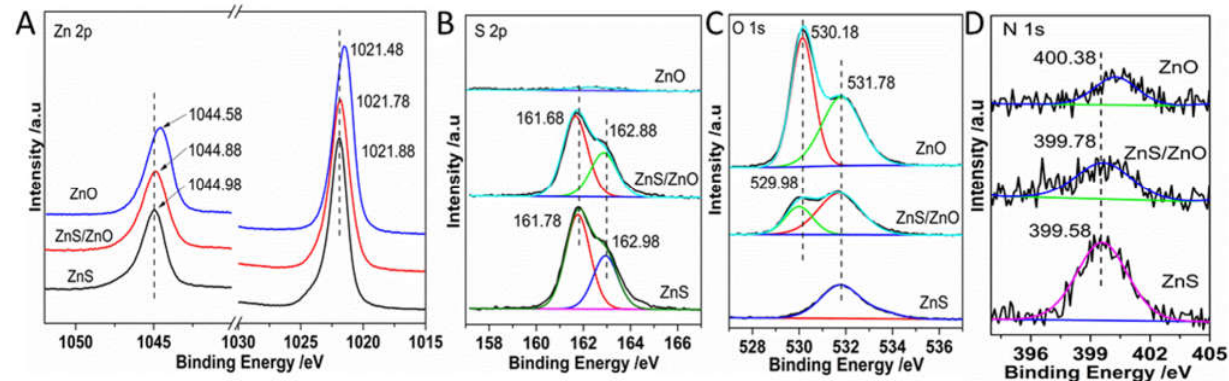
Figure 5. The XPS spectra for the samples. ( A ) Zn 2p, ( B ) S 2p, ( C ) O 1s and ( D ) N 1s. ZnS/ZnO represented the sample of ZnS/ZnO-0.5 h.